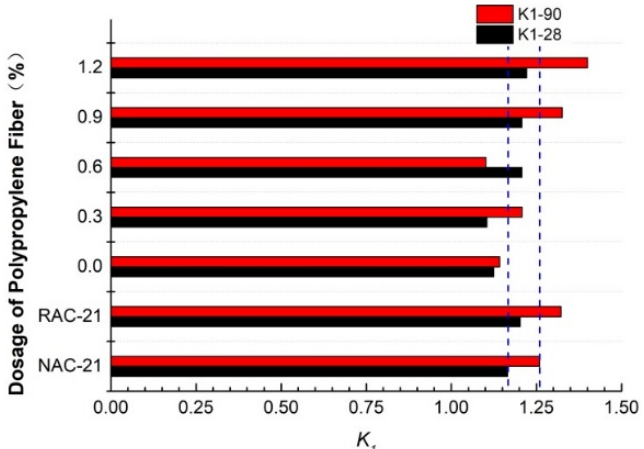
Figure 9. Comparative analysis diagram of curing coefficient in 28 d and 90 d.